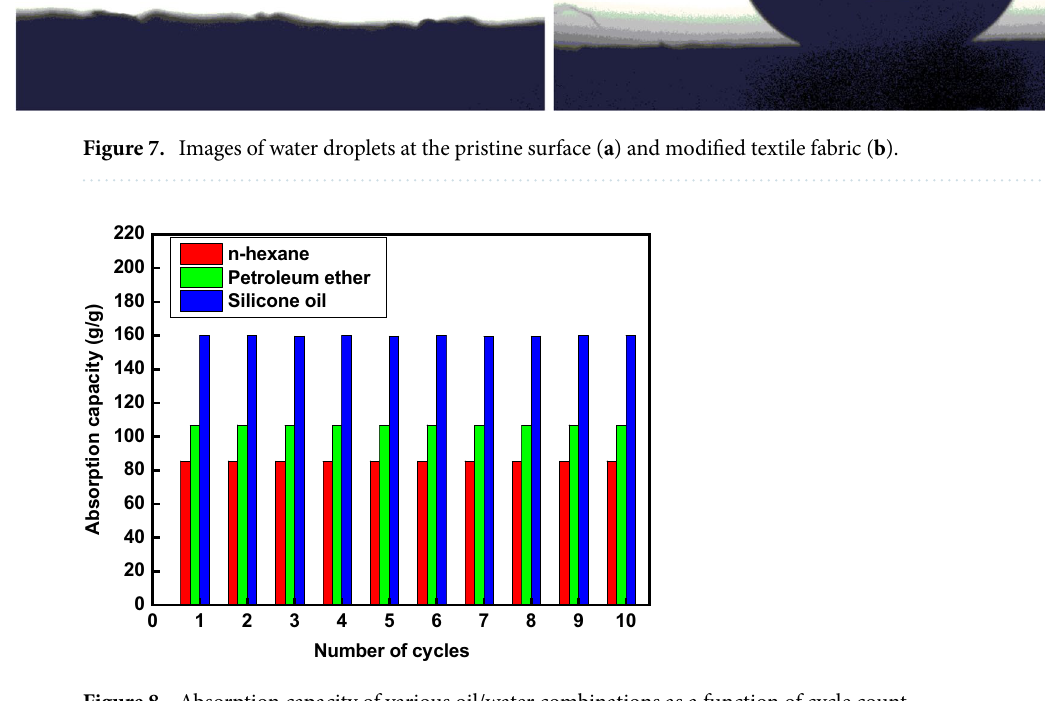
Figure 8. Absorption capacity of various oil/water combinations as a function of cycle